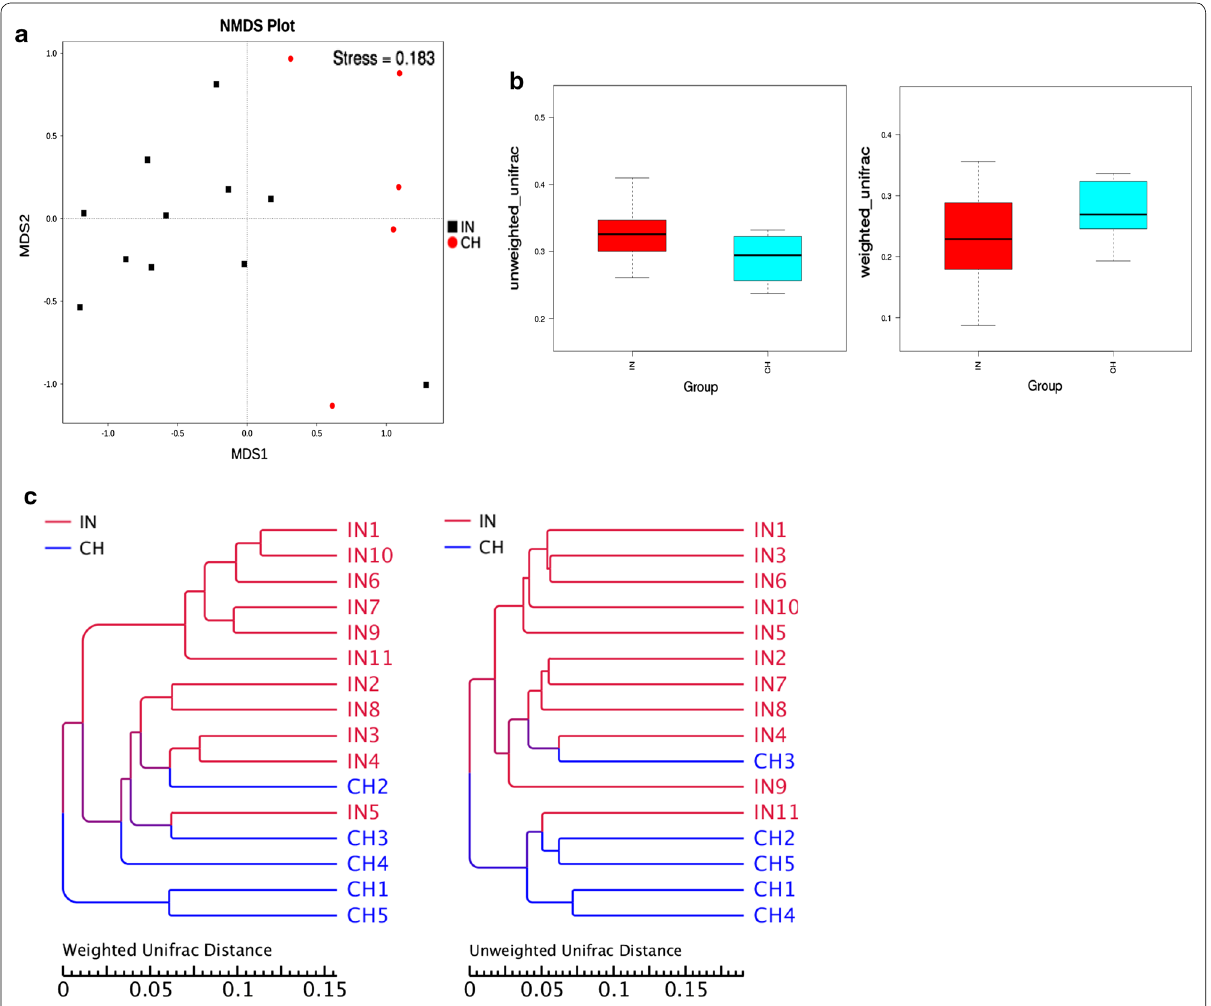
Fig. 5 Gut microbiota composition and relative abundance differ between healthy Indian and Chinese adults. a NMDS plot of the gut bacterial profiles. Each data point represents a subject. The stress factor value < 0.2 shows the reliability of results. b Beta diversity box plots of unweighted and weighted unifrac distances. c UPGMA hierarchical clustering based on unweighted and weighted unifrac distances produced distinct clusters which distinguished Indian adults and Chinese